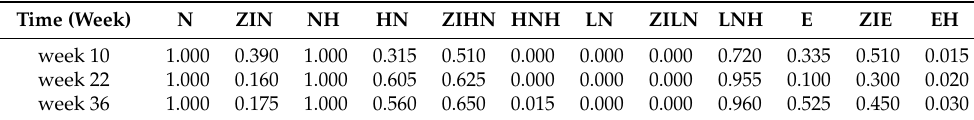
Table 1. KS-test p values for combined data ( N = 52) under 12 distributions at three different weeks.